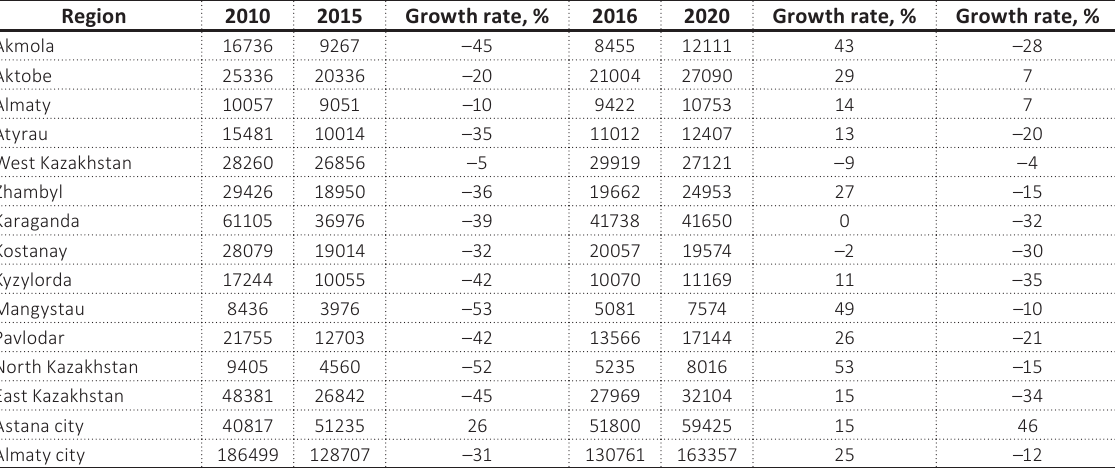
0.002.004.006.008.0010.0012.0014.00 Figure 1. Dynamics of GRP development in the regions of Kazakhstan for 2010, 2015, and 2020 Table 2. Dynamics of changes in the number of university students for